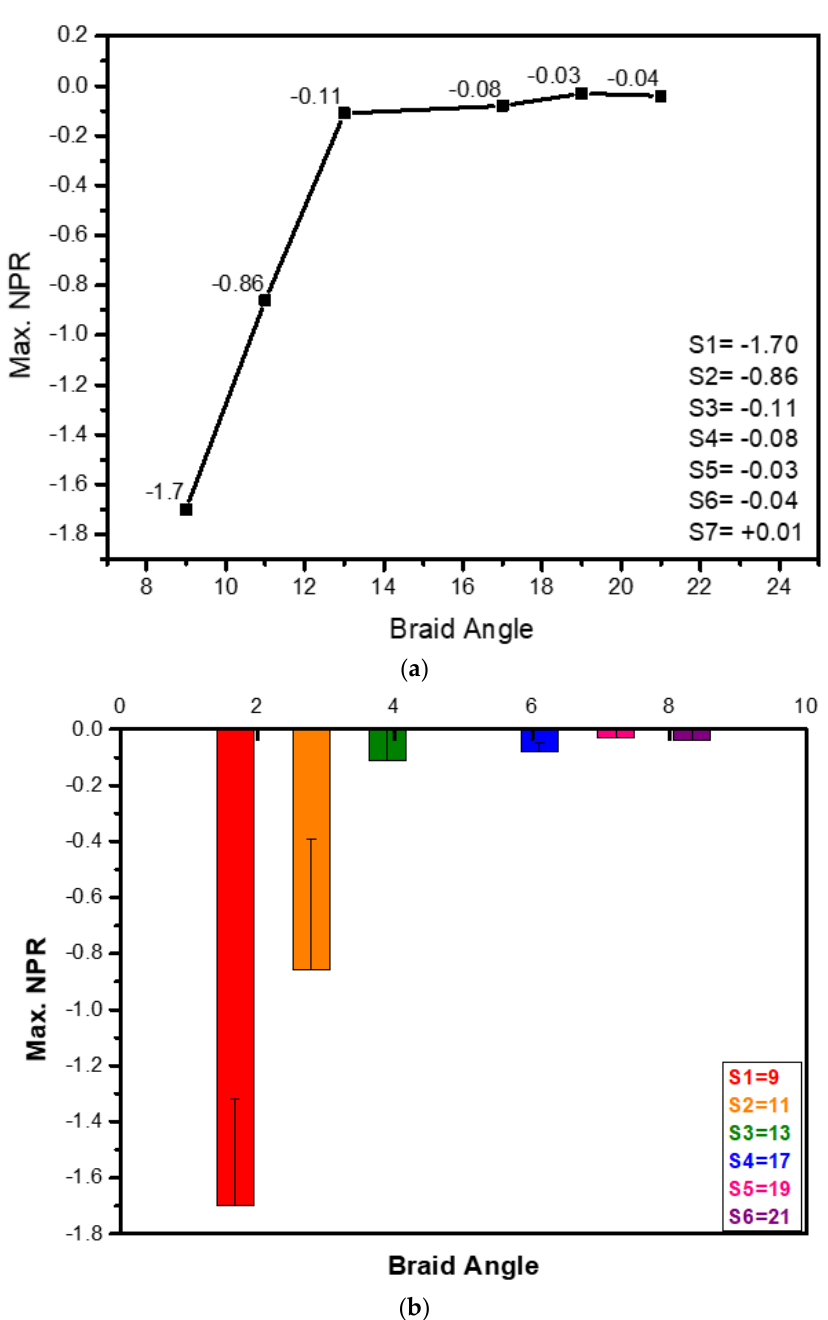
Figure 4. ( a ) Maximum NPR vs. braid angle for samples S1 to S7. ( b ) Error bars for maximum NPR values versus braid